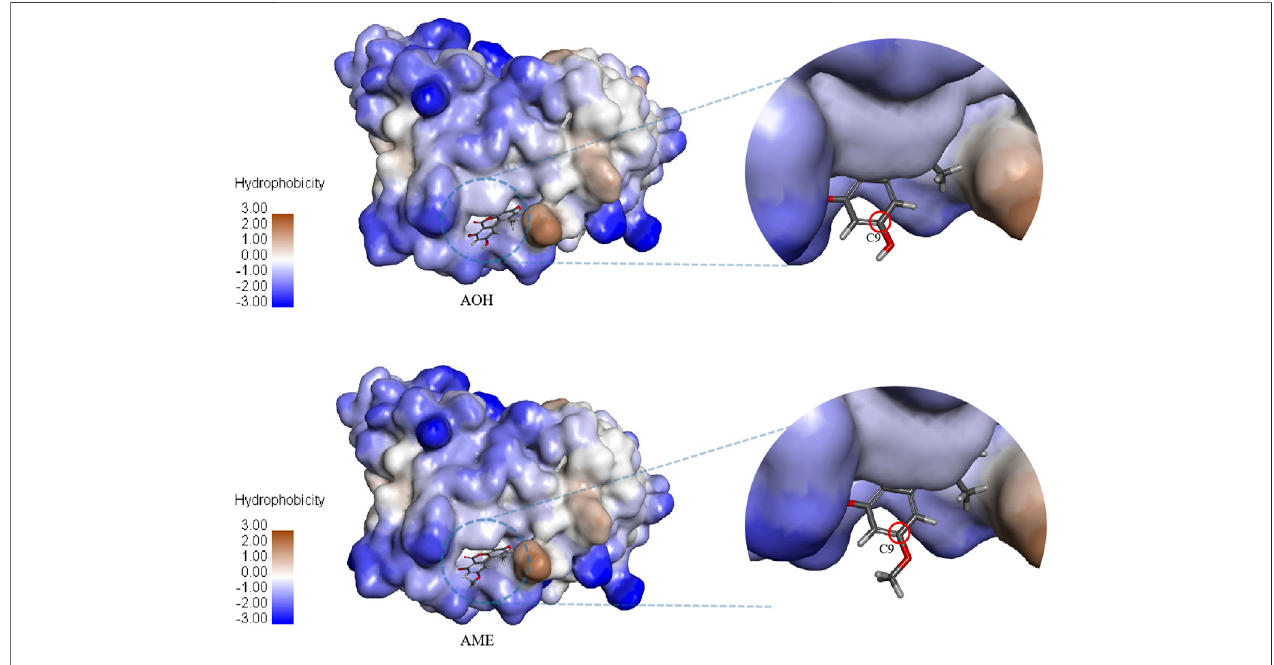
FIGURE 4 | Molecular docking model of AOH/AME and